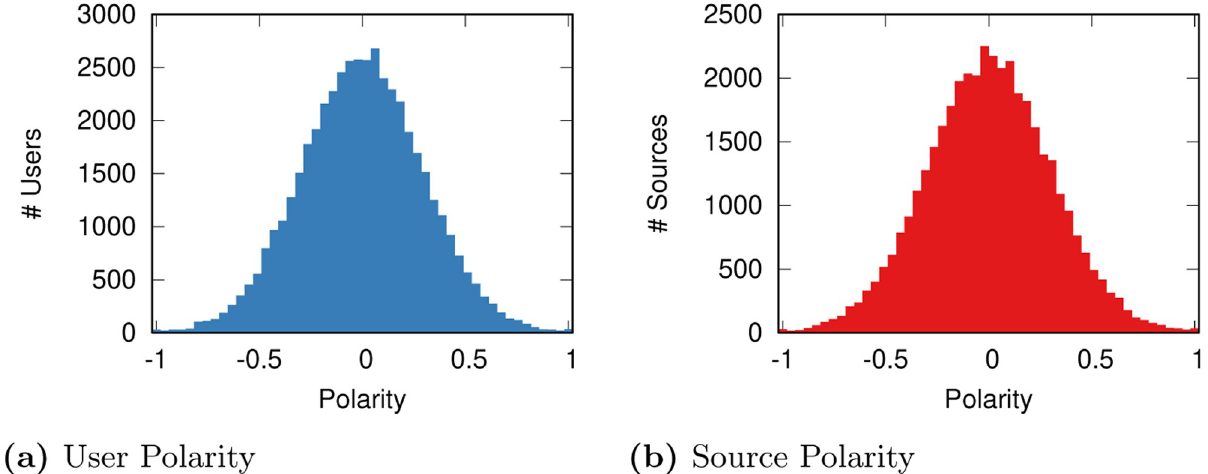
Fig 1. User polarity. Source Polarity. The number of agents (y axis) with a given polarity value (x axis). (a) User Polarity. (b) Source